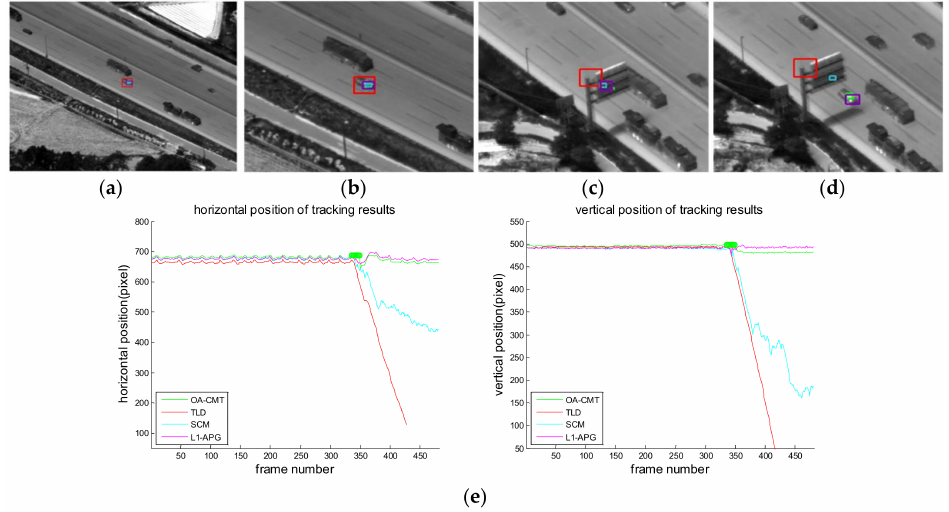
Figure 22. Computer simulation result of imagery ID 7. ( a ) Normal tracking status (original image); ( b ) magnifying interested area; ( c ) OA-CMT turns to memory tracking status as the car is hidden by the traffic sign; ( d ) L1-APG and OA-CMT re-locks target successfully while TLD and SCM lost the target; ( e ) tracking trajectories of each